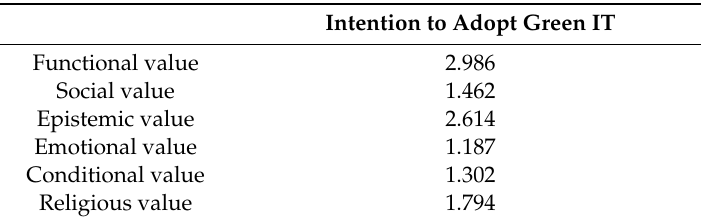
Table 5. Assessment of Collinearity.